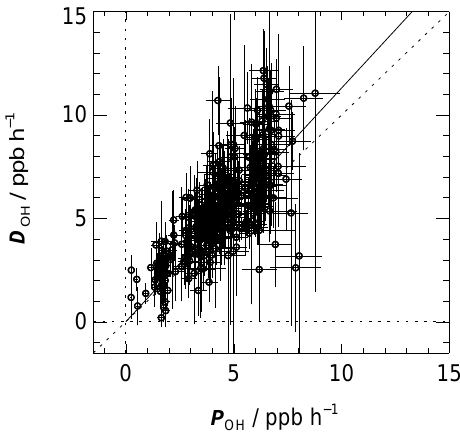
Figure 2. Correlation of OH destruction rates ( D OH ) and produc- tion rates ( P OH ) from all SAPHIR experiments with CO in 2010 and 2011. The solid line corresponds to a mean ratio of 1.13, the dashed line indicates a 1:1 ratio. The total number of data points is